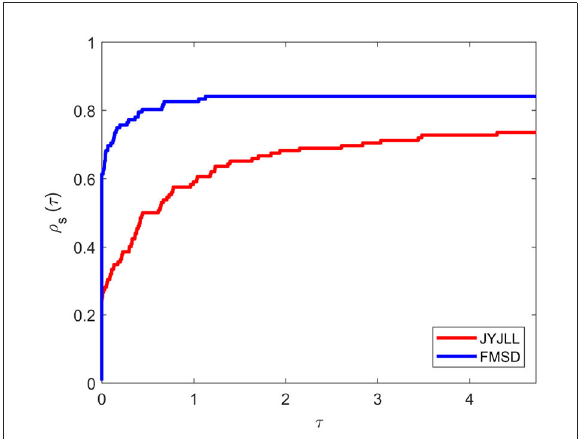
FIGURE1 Performance profiles on NOI.